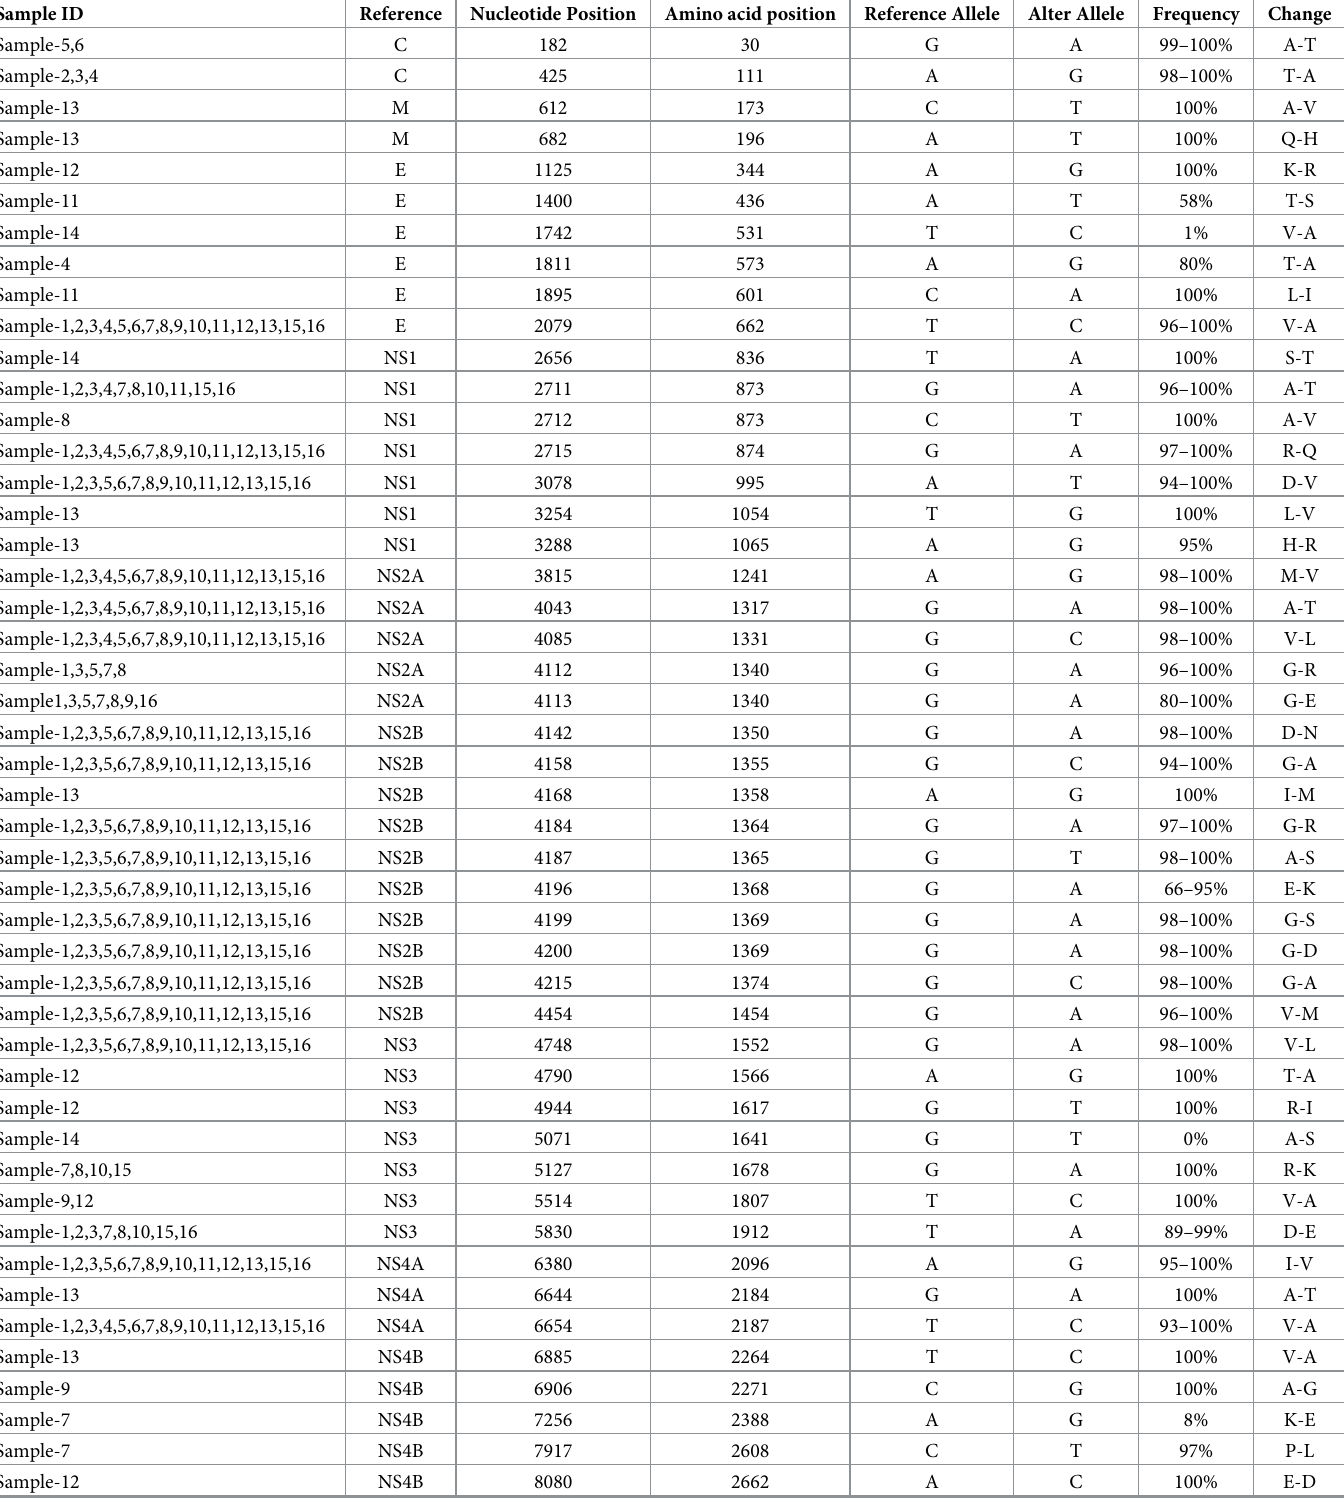
Table 4. Non-synonymous variant ( > 1%) alleles shared among the DENV-1 isolates in this